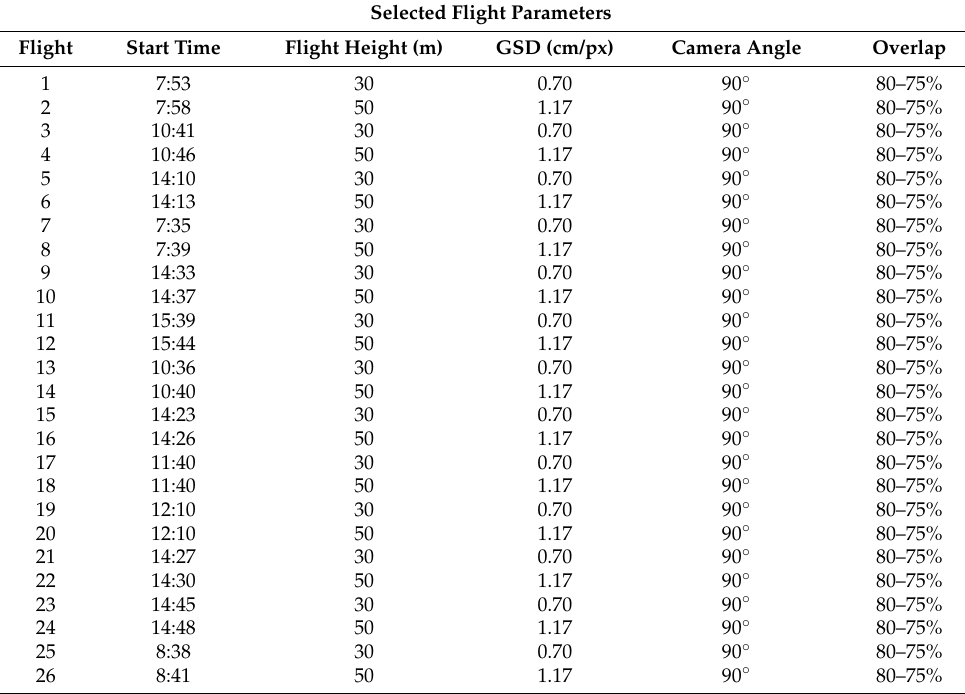
Figure 5. ( A ) Flight plan at 30 m. ( B ) Flight plan at 50 m. Table 4. Selected flight parameters. Selected Flight Parameters